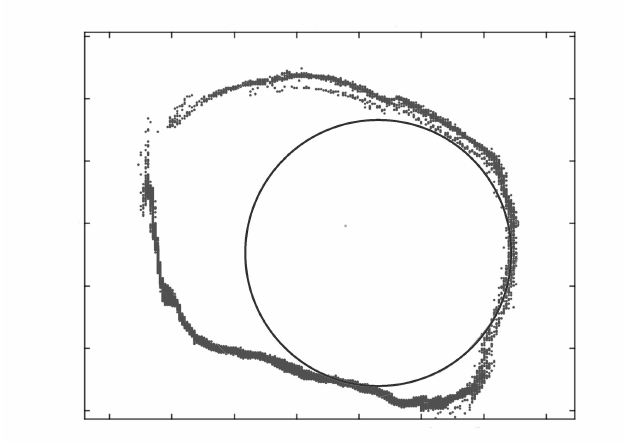
Figure 15. The cross-section of a tree at 1.3 m above the ground. The severe irregularity leads to an underestimation of the diameter using our